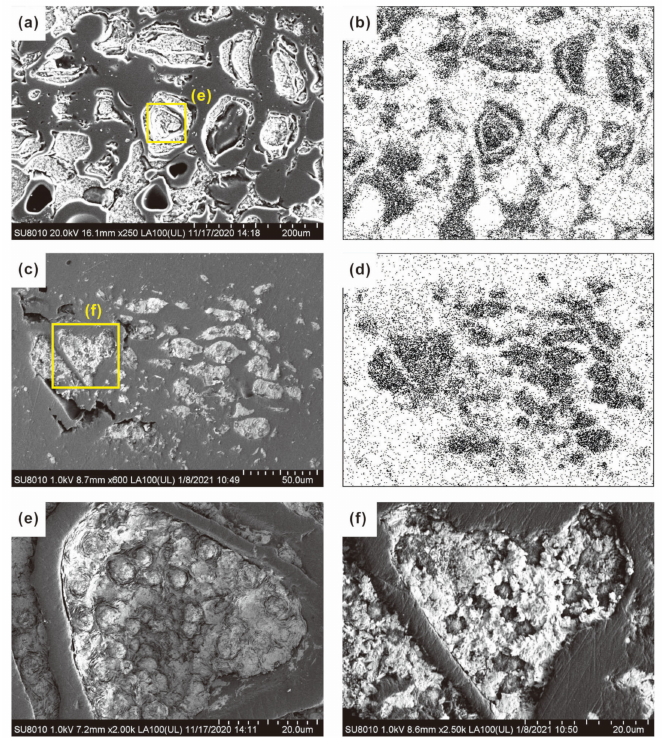
Figure 15. SEM backscattered images of Sr-bearing clay minerals in the Tashan coals and mapping analysis: ( a ) Sr-bearing kaolinite spherules filling in pores of fusinite; ( b ) Sr mapping analysis of ( a ), black dots refer to the position where Sr was detected; ( c ) Sr-bearing kaolinite filling in pores of macerals; ( d ) Sr mapping analysis of ( c ), black dots refer to the position where Sr was detected; ( e ) and ( f ) are close-ups of the selected area in ( a , c ),